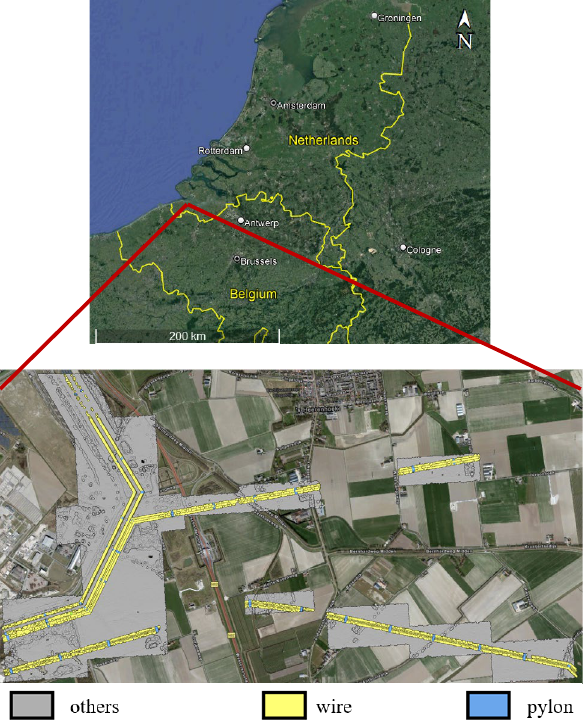
Figure 2. Overview of the point cloud data of Borssele, Netherlands with three manually labelled